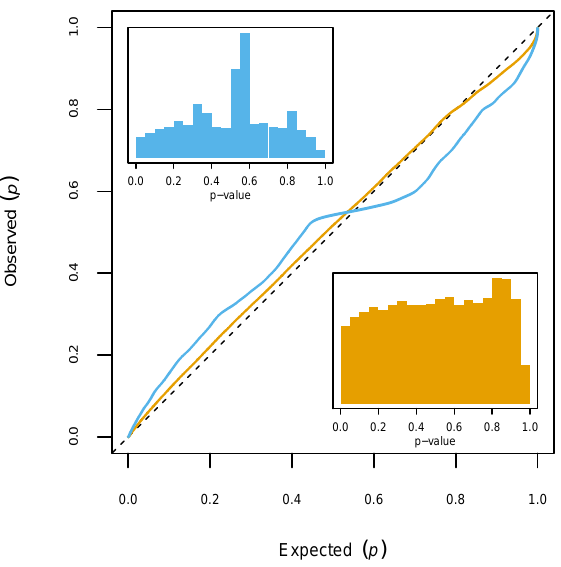
Figure 6 – Effect of a filter on minor allele frequency (MAF) on the distribution of p - values. p -values calculated from 100 simulation replicates of a neutral outcrossing pop- ulation of N = 500 diploid individuals, sampled twice with τ = 25 generations between samples. The blue histogram shows the distribution of p -value using all loci, with cor- responding blue line in the QQ-plot. The orange histogram shows the distribution of p -value using loci with a minimum global allele frequency of 0.05 , with corresponding orange line in the